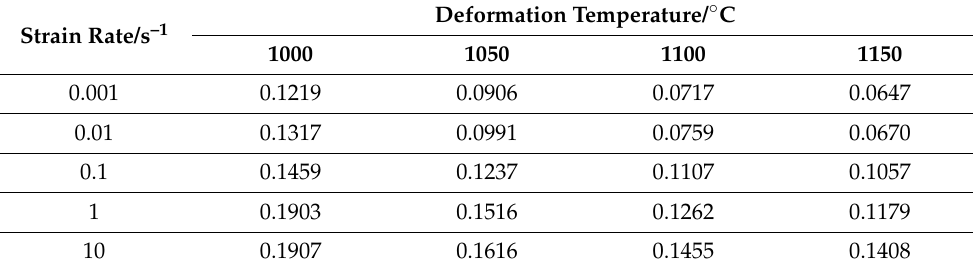
Figure 13. Relationship between ln θ − ε and − ∂ ( ln θ ) / ∂ε − ε for S280 steel at a strain rate of 10 s –1 and different deformation temperatures: ( a ) ln θ − ε ; ( b ) − ∂ ( ln θ ) / ∂ε − ε . Table 2. Dynamic recrystallization critical strain for S280 steel.